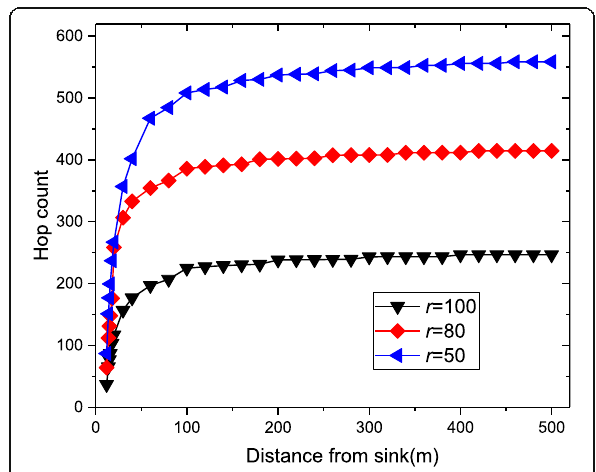
Fig. 18 Number of detection hops created by remaining energy (different r